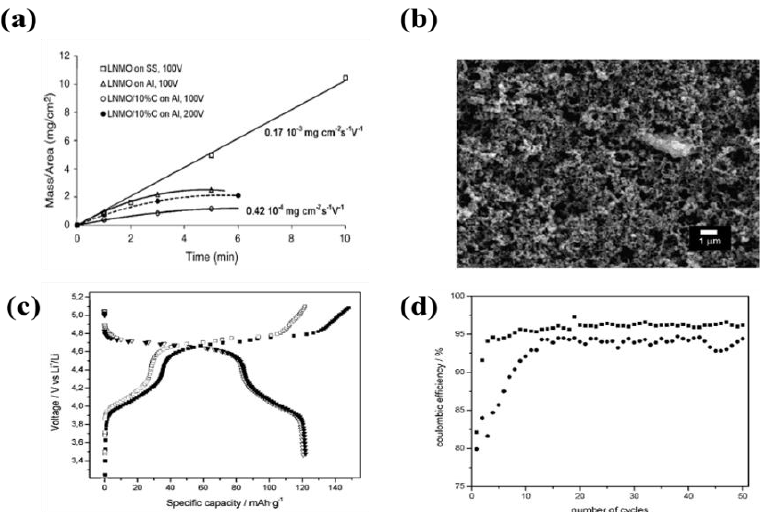
Figure 5. LiNi 0.5 Mn 1.5 O 4 /carbon composite prepared by EPD as the cathode for Li-ion batteries: ( a ) EPD kinetics of the LiNi 0.5 Mn 1.5 O 4 deposition on various substrates; ( b ) Top view of the LiNi 0.5 Mn 1.5 O 4 /carbon composite electrode; ( c ) Charge-discharge curves for the EPD deposits cycled over the voltage range, 3.5–5.0 V at a C/6 rate; first charge and discharge (black), second charge and discharge (white); ( d ) Coulombic efficiency of LiNi 0.5 Mn 1.5 O 4 /carbon composite electrode with the number of cycles. Standard electrode (●), electrode fabricated by EPD ( ■ ) (charge/discharge rate C/6).